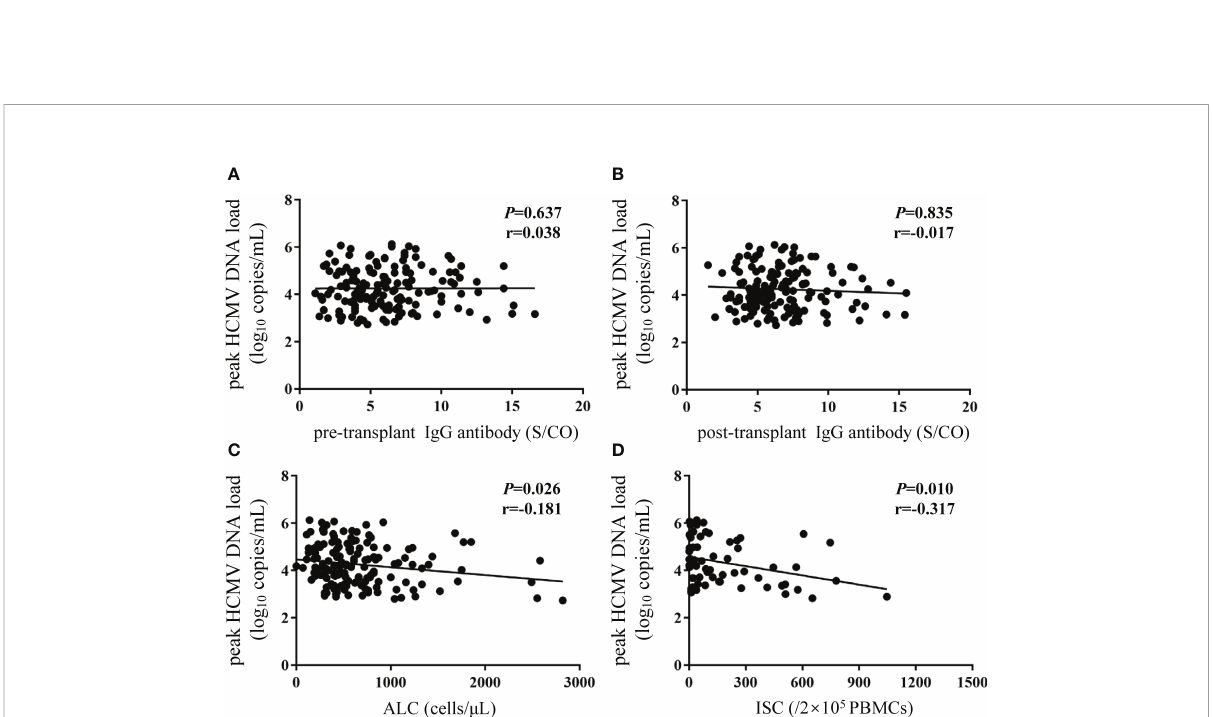
FIGURE 5 Correlations between peak HCMV DNA load and different biomarkers. Y-axis corresponds to log10 scale. The peak HCMV DNA load was de fi ned as the highest HCMV DNA level recorded after transplantation. (A, B) pre- and post-transplant HCMV IgG antibody concentrations; (C) ALC; (D) ISCs. The P value indicates level of signi fi cance and r, the correlation coef fi cient. HCMV, human cytomegalovirus; ALC, absolute lymphocyte count; ISCs, HCMV speci fi c IFN- g secreting